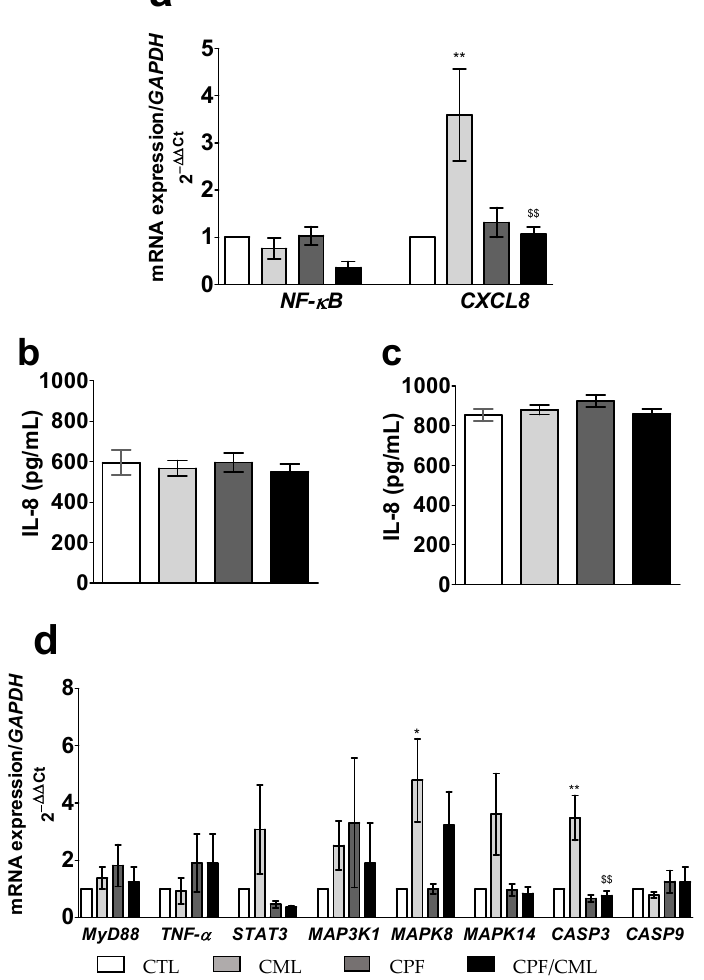
Figure 4. Effect of a 6 h incubation with CML (300 μM) and/or CPF (300 μM) on the relative mRNA expression of genes coding for NF-κB and CXCL8 ( a ) measured by qPCR, and of IL-8 secretion measured by ELISA, in both the apical ( b ) and basal ( c ) media. Relative mRNA expression of genes involved in the pro-inflammatory and pro-apoptotic signaling path- ways measured by qPCR from the Caco-2/TC7 & HT29-MTX co-culture ( d ). Data are expressed as the mean ± SEM ( n = 12). The level of gene expression is expressed as the fold induction over the CTL group set at 1. *, ** statistically significant difference ( p < 0.05; p < 0.01 CML vs. CTL); $$ statistically significant difference ( p < 0.01 CML vs. CPF/CML). CML, N (6)- Carboxymethyllysine; CPF, Chlorpyrifos; CTL, control; CASP3 , Caspase 3; CASP9 , Caspase 9; CXCL8 , Interleukin 8; MAP3K1 , mitogen-activated protein kinase 1; MAPK8 , mitogen-activated protein kinase 8; MAPK14 , mitogen-activated protein kinase 14, also called p38-α; MyD88 , myeloid differentiation primary response gene 88; NF-κB ; nuclear factor- kappa B; STAT3 , signal transducer and activator of transcription 3; TNF-α , tumor necrosis factor α.